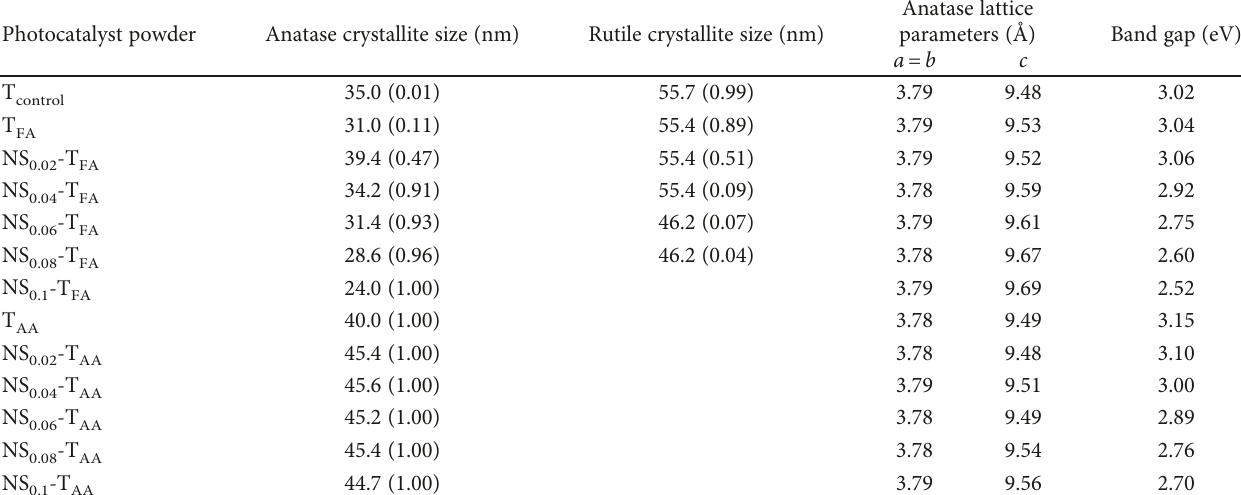
Figure 1: X-ray di ff raction patterns of (a) T calcined at 700 ° C. Table 1: Crystallite size, phase fractional compositions (values shown in parentheses), anatase phase lattice parameters, and band gap values of control and carboxylic acid modi fi ed NS-codoped (NS) calcined at 700 °